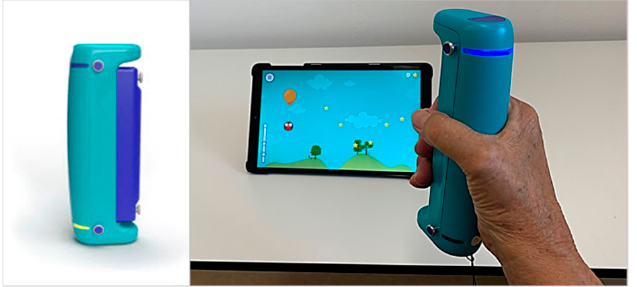
Figure 1. ( Left side ): GripAble. The device measures 55 mm × 35 mm × 170 mm and weighs 240 g. Right side: Participant playing Balloon Buddies with the GripAble (for more details see Ref. [33]).